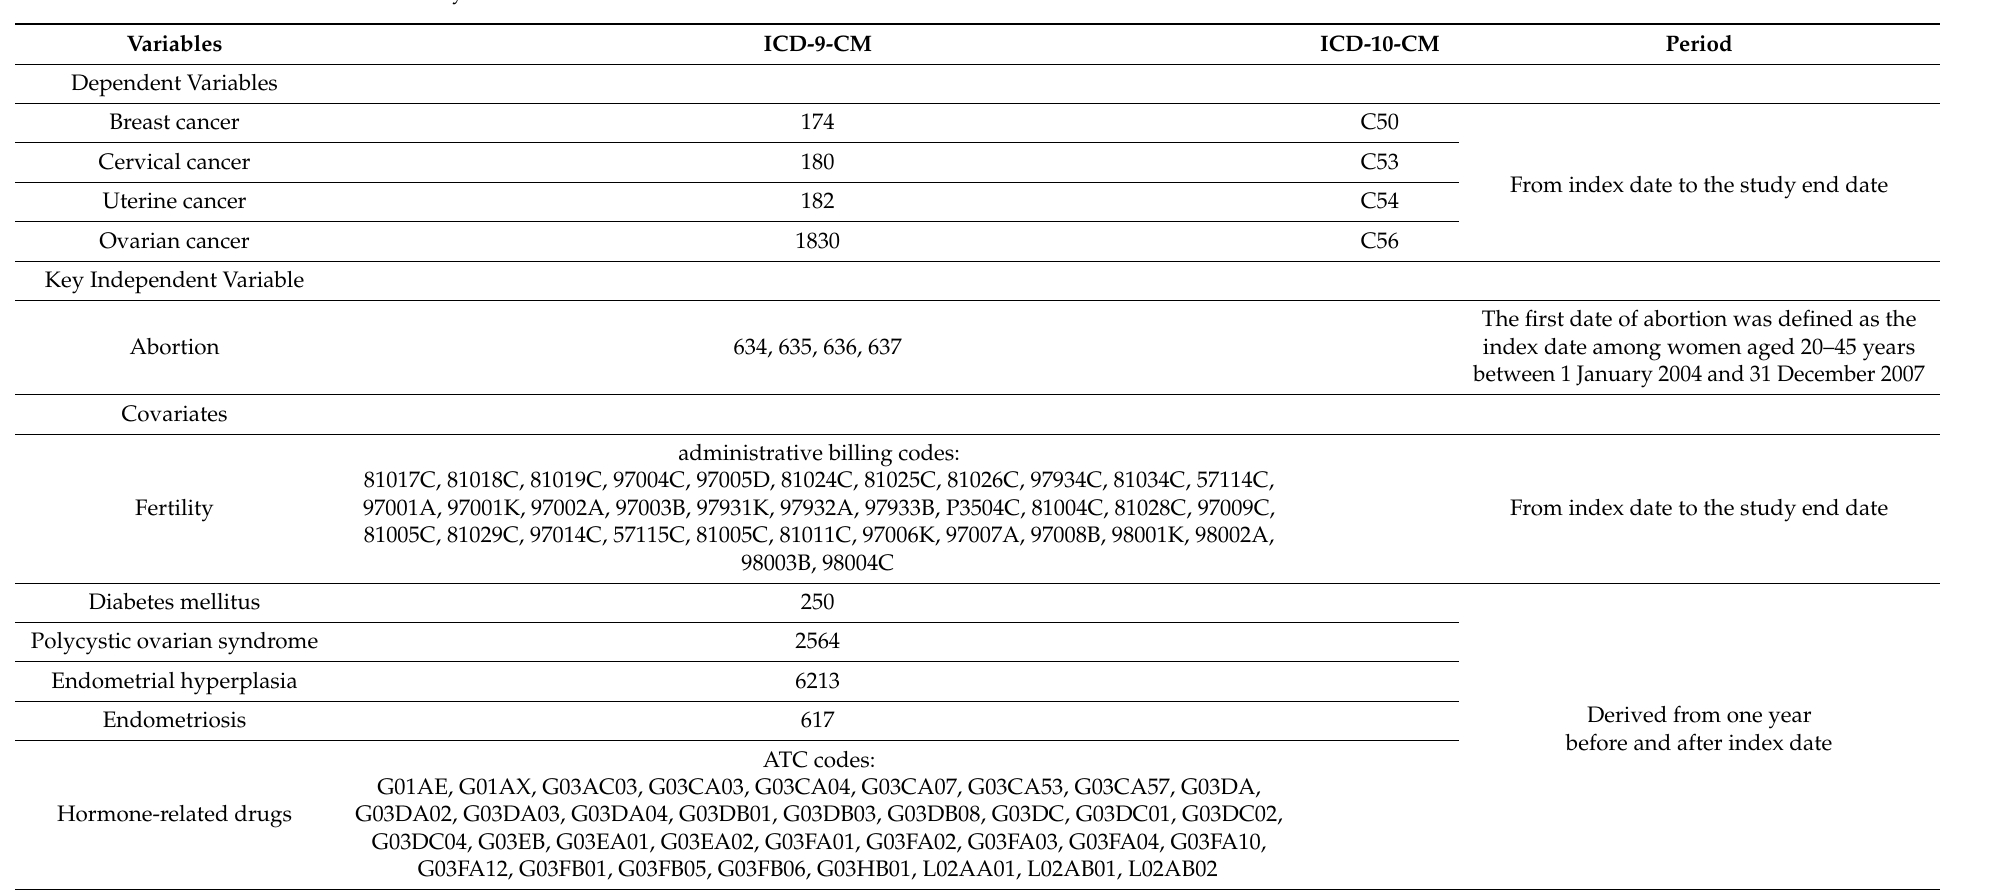
Table A1. ICD-9-CM, ICD-10-CM disease diagnosis codes, administrative billing codes for delivery (fertility), and ATC codes for hormone-related drugs considered in this